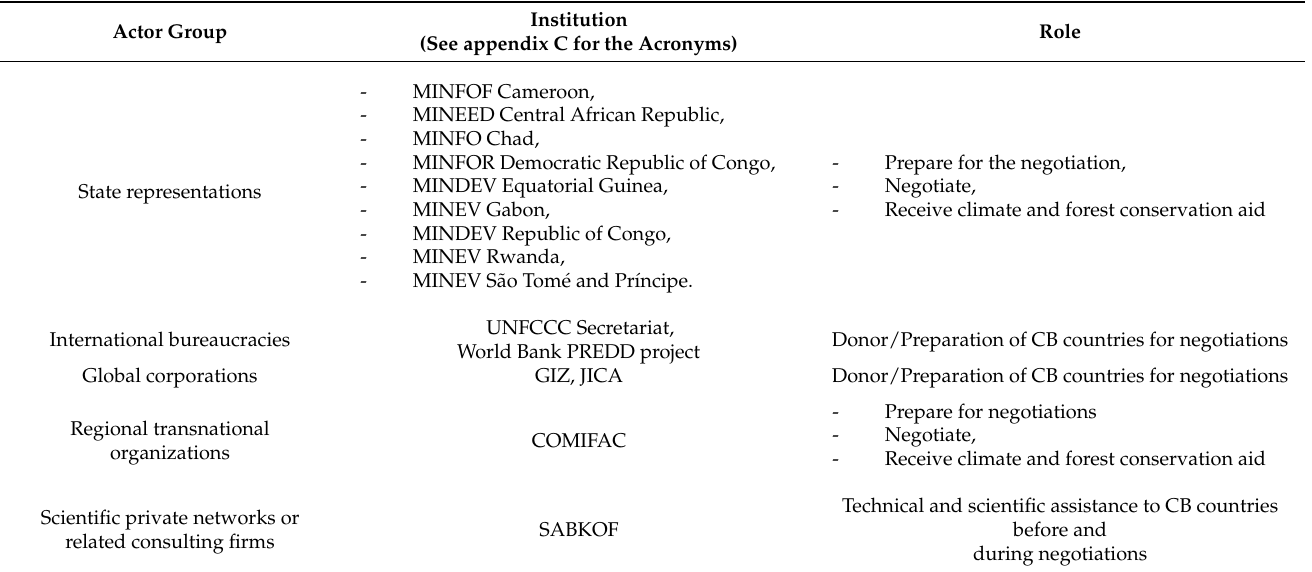
Table 2. Typology and role of the most relevant actors of forest diplomacy in the Congo Basin countries. Actor